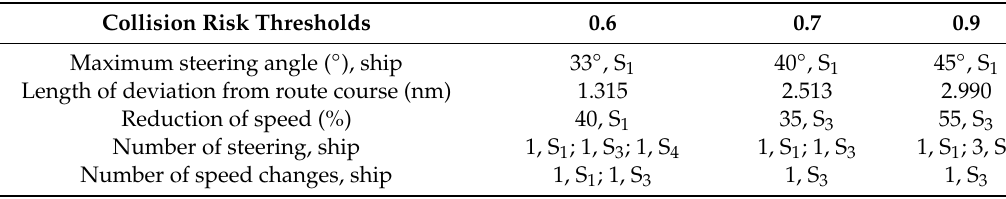
Table 7. Comparison of the results of scenarios